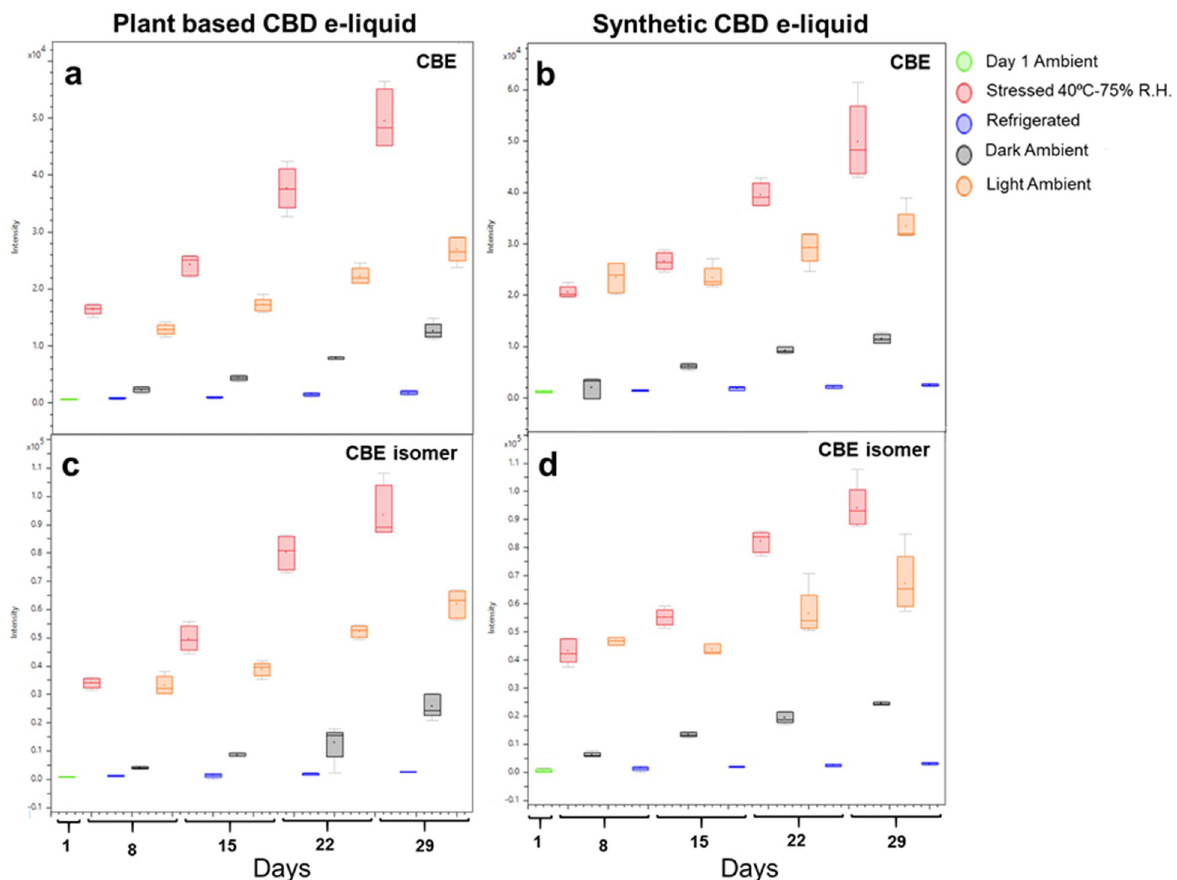
Figure 5. Trends in levels of CBE and CBE isomer in CBD-containing e-liquids over 29 days of storage under four different conditions. ( a ) CBE in plant-based CBD e-liquid; ( b ) CBE in synthetic CBD e-liquid; ( c ) CBE isomer in plant-based CBD e-liquid; and ( d ) CBE isomer in synthetic CBD